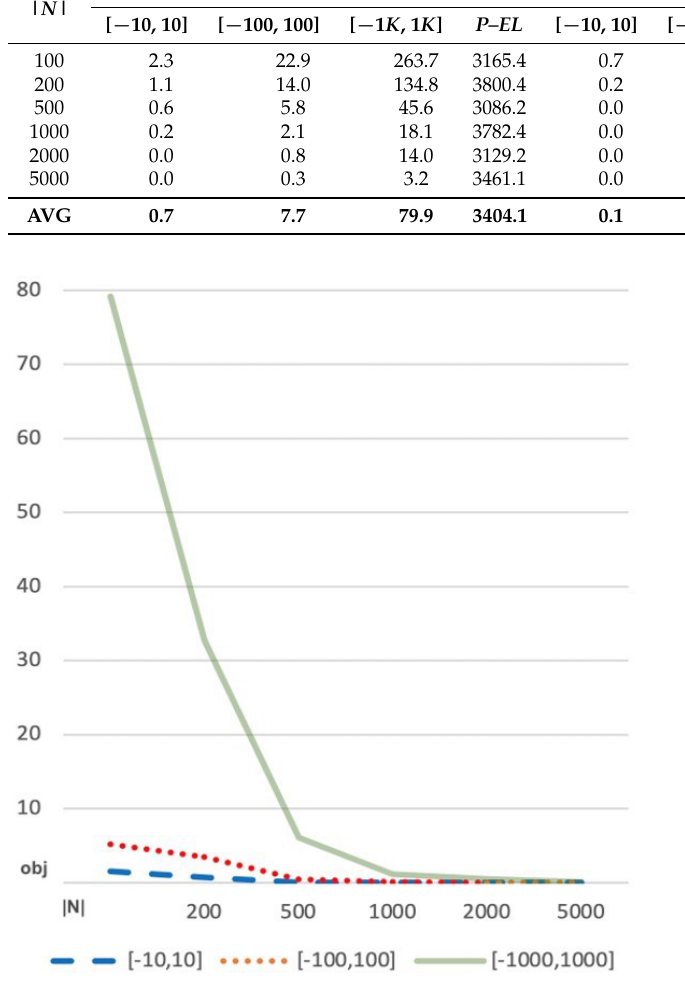
Figure 4. Objective function values obtained by CH − IPa compared to the size of the